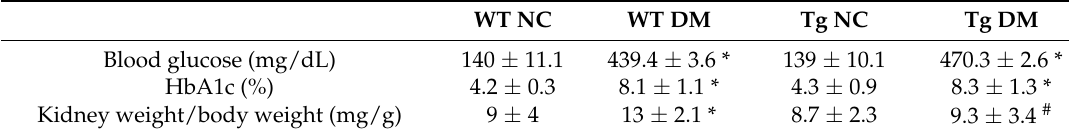
Table 1. Biochemical properties and the kidney-to-total body weight ratios of study animals.